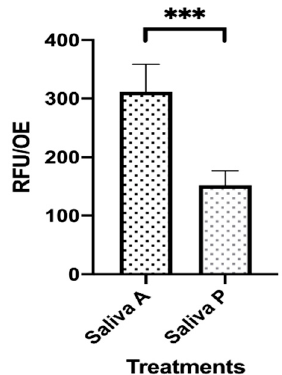
Figure 1. Microbial adhesion onto saliva-contaminated orthodontic elastics (OE). Two sets of OE were exposed to saliva A and P for 1 h at 37 °C. During that time, fluorescence staining of viable cells was allowed by Carboxy-fluorescein Diacetate, Acetoxymethyl Ester (CFDA) addition. Then, the OE were washed with warm saline and transferred to new wells. The plate was read by the Fluoroskan reader and the fluorescence signal was recorded. The depicted values represent the mean (RFU/OE) ± SEM of 48 replicates obtained by 3 independent experiments. *** p < 0.001.